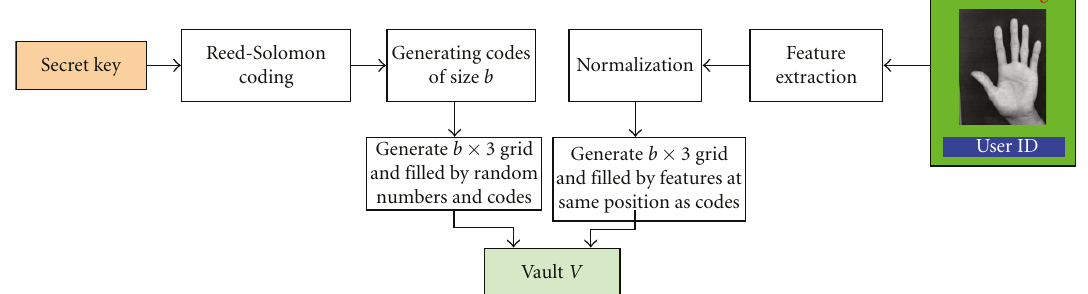
Figure 2: Block diagram for locking of the